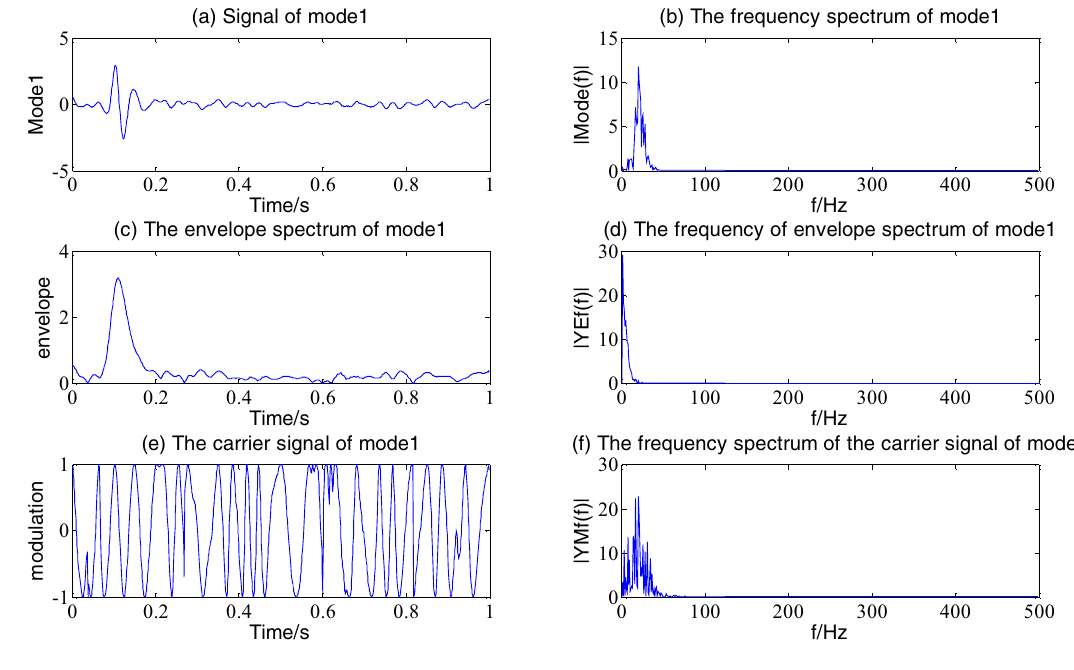
Figure 4. The envelope demodulation distribution diagram of mode1.